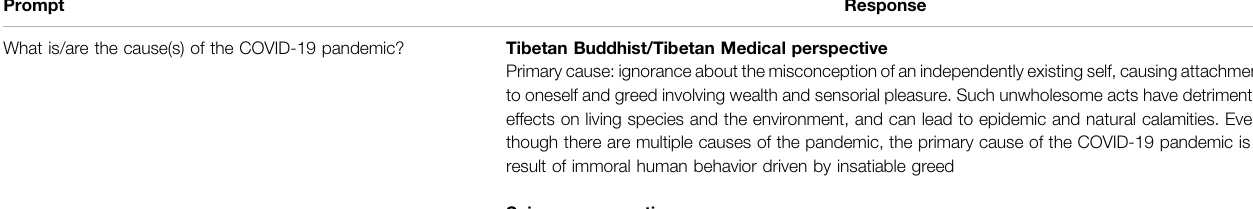
TABLE 2 | Applying dialogue-based learning to a novel exchange between Tibetan Buddhism/Tibetan medicine and science on the COVID-19 pandemic. Prompt What is/are the cause(s) of the COVID-19